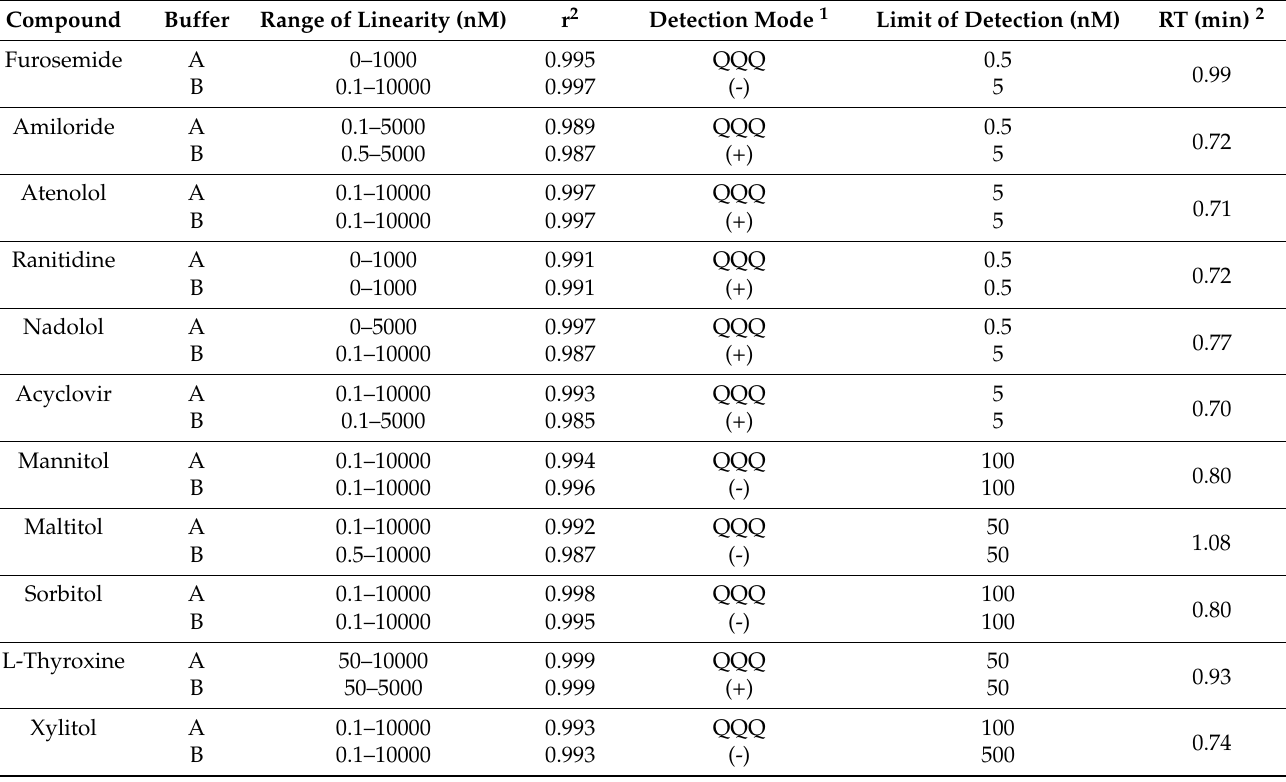
Table 3. Range of linearity and limit of detection of detectable compounds in assay buffer A or B.